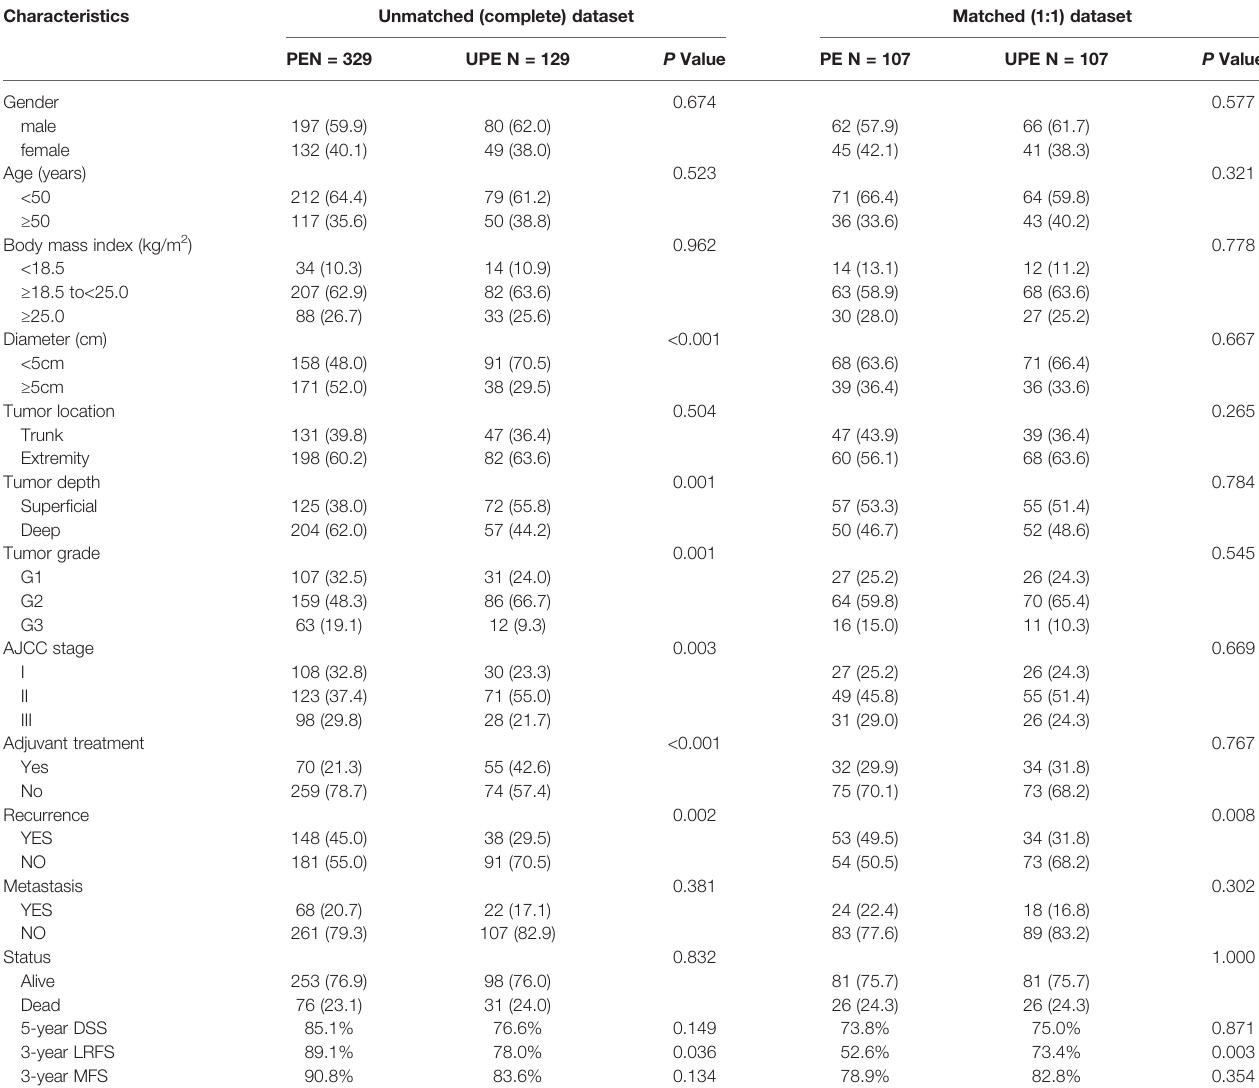
TABLE 2 | Comparison of clinicopathological characteristics between planned excision (PE) group and unplanned excision group (UPE) before and after propensity score matching.